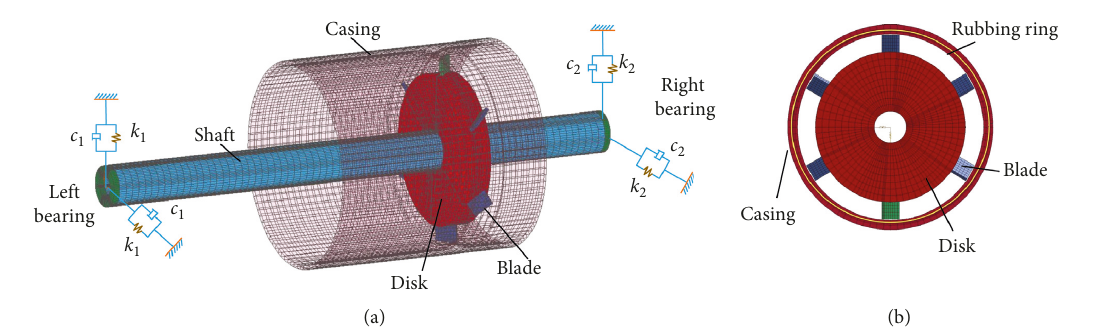
Figure 4: FE model of rub-impact. (a) Full view. (b) Section